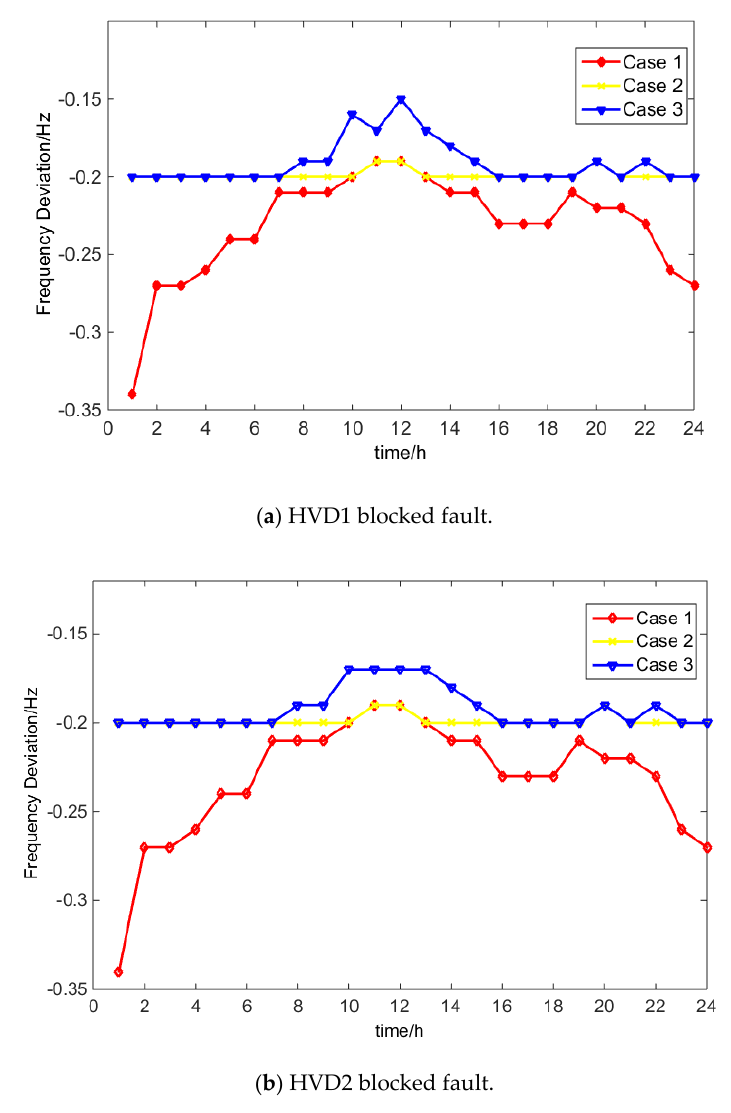
Figure 4. Frequency deviation after HVDC 1 and 2 blocked fault.